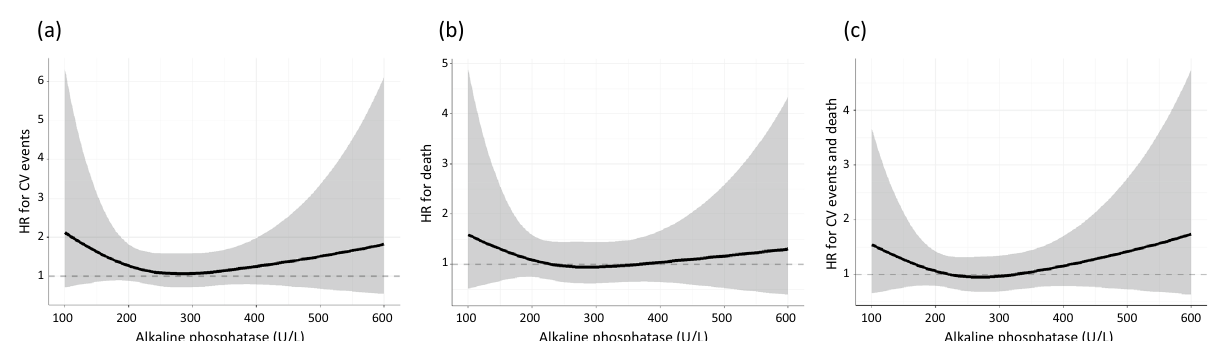
Figure 3. Alkaline phosphatase does not modify the effect of alfacalcidol on the cardiovascular outcomes and mortality. Cubic spline curves for the hazard ratios of the alfacalcidol groups vs. the control group in terms of ( a ) cardiovascular events, ( b ) all-cause death, and ( c ) composite of cardiovascular events and all-cause death are depicted with 3 knots at 10th, 50th, and 90th percentiles of ALP. The Cox models were adjusted for age, sex, body mass index, systolic blood pressure, dialysis vintage, diabetes mellitus, prior history of cardiovascular events, C-reactive protein, serum albumin, serum phosphate, serum corrected calcium, intact parathyroid hormone, high-density lipoprotein cholesterol, hemoglobin, and use of erythropoiesis-stimulating agents and intravenous iron therapy. The lines and gray zones indicate the hazard ratios and 95% confidence intervals. P -values for the coefficient of the cross-product term between the treatment assignment and alkaline phosphatase were 0.54, 0.74, and 0.50 for cardiovascular events, all-cause death, and composite of cardiovascular events or all-cause